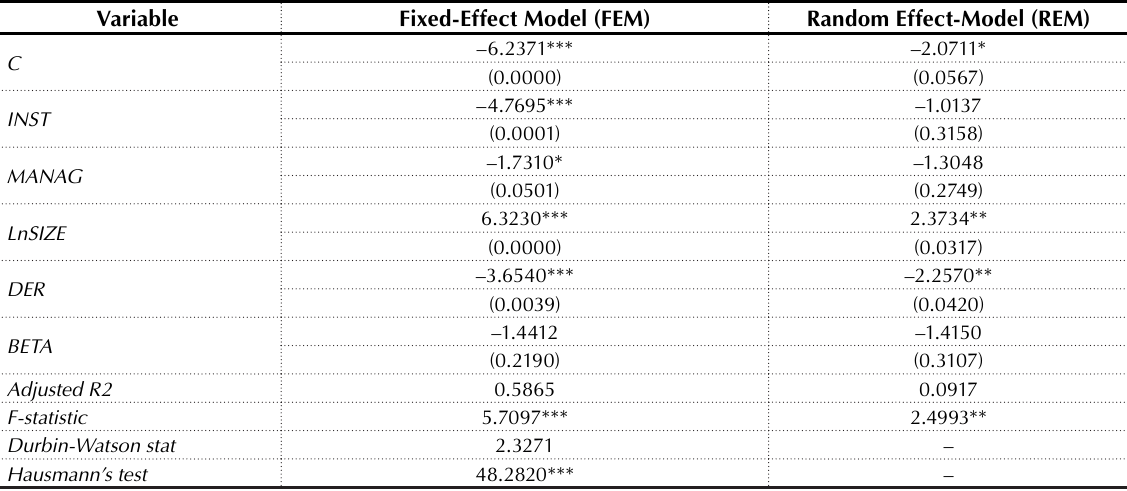
Table 2. Regression analysis